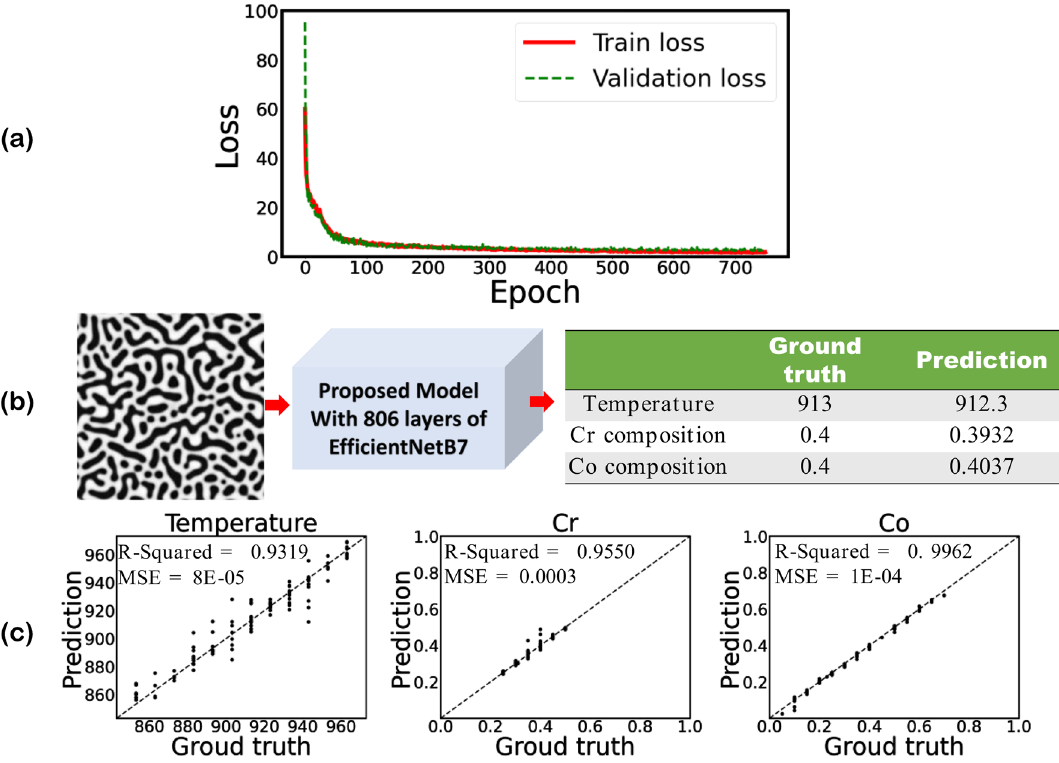
Figure 8. ( a ) Training and validation loss per each epoch, ( b ) prediction of temperature and chemical compositions for a random test dataset, and ( c ) the parity plots of temperature and chemical compositions for the testing dataset from the proposed model when first 806 layers of EfficientNetB7 are used for microstructures’ feature extraction (The size of the input images are 224 × 224